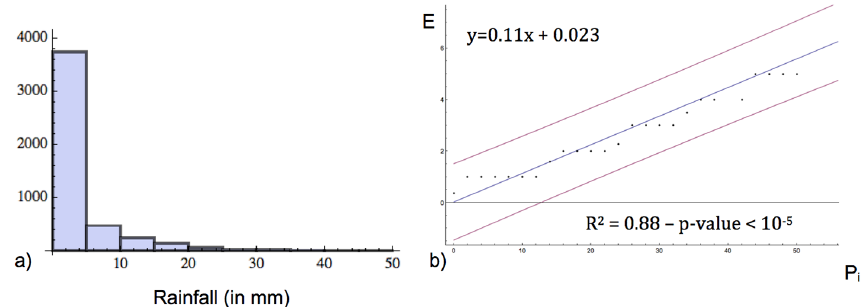
Figure 6. (a) Histogram of rainfall for Burgundy; (b) application of the method to a virtual database with 56% of days with events and rain that fits the empirical distribution of Burgundy rainfall. For these days, the rockfall and rainfall magnitudes are 100% correlated.